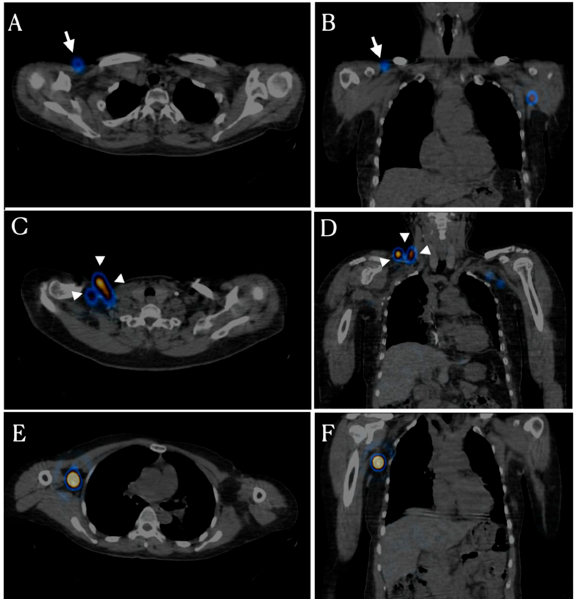
Figure 2. SPECT/CT findings of two types of bypass circulation. ( A , B ) The infraclavicular type shows radioactivity on the deltopectoral groove (arrow) below the right clavicle. ( C , D ) The